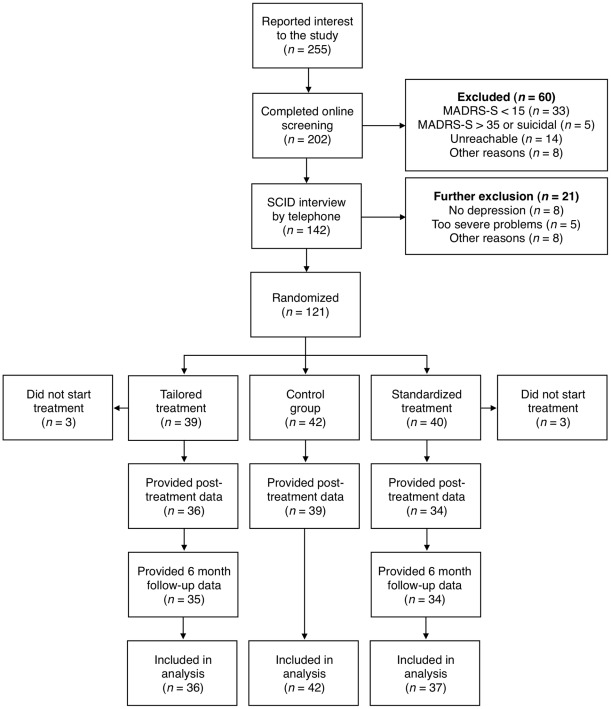
Participant flow and reasons for dropping out throughout the trial.Abbreviations: MADRS-S: Montgomery-Åsberg Depression Rating Scale–Self-rated version; SCID: Structured Clinical Interview for DSM-IV Axis I Disorders.